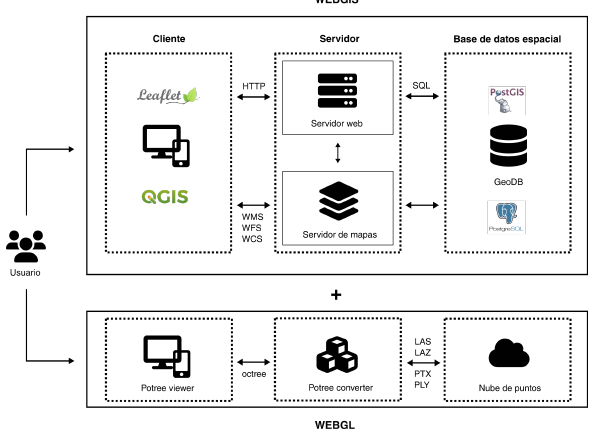
Figure 5. Conceptual structure of the web platform created for the Aragonese Mud´ejar